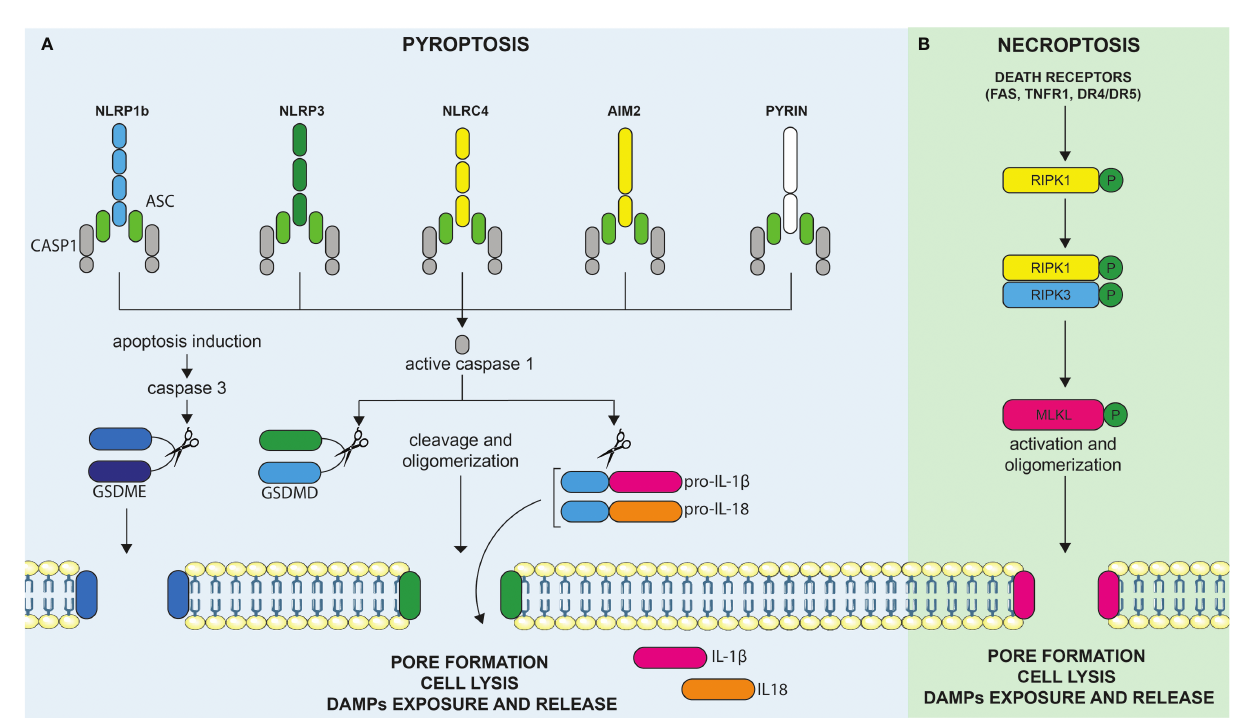
FIGURE 2 | Molecular mechanisms leading to the induction of pyroptosis and necroptosis. (A) Cytoplasmic sensors of DAMPs and PAMPs include, but are not restricted to, NOD-like receptors (NLRs), the absent in melanoma-2 (AIM2)-like receptors, and proteins of the pyrin family. Upon binding to their speci fi c DAMPs or PAMPs ligands, these cytoplasmic sensors, such as NLRP1b, NLRP3, NLRC4, AIM2, and pyrin, assemble into an in fl ammasome multimeric protein complex, containing or not the adaptor proteins ASC, further leading to the recruitment and activation of pro-caspase-1. Activated caspase-1 can cleave and activate the leaderless cytoplasmic cytokines pro-IL-1 b and pro-IL-18, leading to their maturation. Active caspase-1 (an others in fl ammatory caspases) also cleaves gasdermin D (GSDMD), the recently identi fi ed pyroptosis executioner, resulting in the liberation of its N-terminal pore forming domain (N-GSDMD) from the auto-inhibitory C-terminal domain. Liberation of the N-GSDMD induces its auto-oligomerization and translocation to the cell membrane to form a non-selective pore that contributes to cell lysis, mature IL-1 b /IL-18 release, as well as to the liberation of DAMPs in the extracellular milieu. GSDME, another member of the gasdermin family, is not cleaved by in fl ammatory caspases but can be cleaved by activated caspase-3 upon induction of apoptosis. Hence, the level of expression of GSDME directly determines the cellular fate between apoptosis or GSDME mediated-pyroptosis. (B) Necroptosis represents another in fl ammatory form of cell death and is mediated by Mixed lineage kinase domain-like (MLKL). Necroptosis can be triggered by the same death receptors (DRs) that are known to induce extrinsic apoptosis (e.g., FAS, TNFR1, DR4/DR5) but occur only when the initiator caspase-8 is blocked, as for instance in tumor or infected cells. In these circumstances, activation of death receptors results in the phosphorylation of RIPK1, RIPK3, and, fi nally, MLKL. Phosphorylation of MLKL culminates, as for pyroptosis, in the formation of membrane pores (although of smaller size as compared to pyroptosis). Membrane permeabilization to cations further induces cell swelling and osmolysis, ultimately leading to membrane rupture and release of proin fl ammatory DAMPs in the extracellular milieu, triggering immune